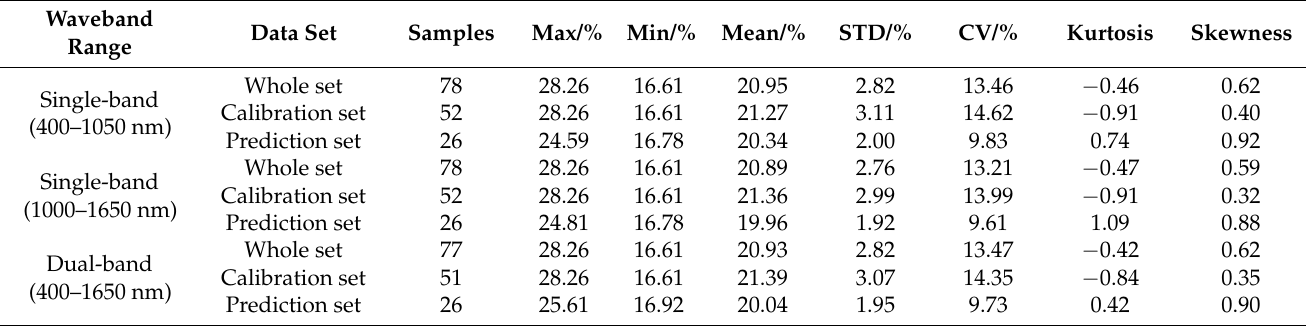
Table 1. Statistical characteristics of tea polyphenol content of the calibration and prediction sets in different waveband